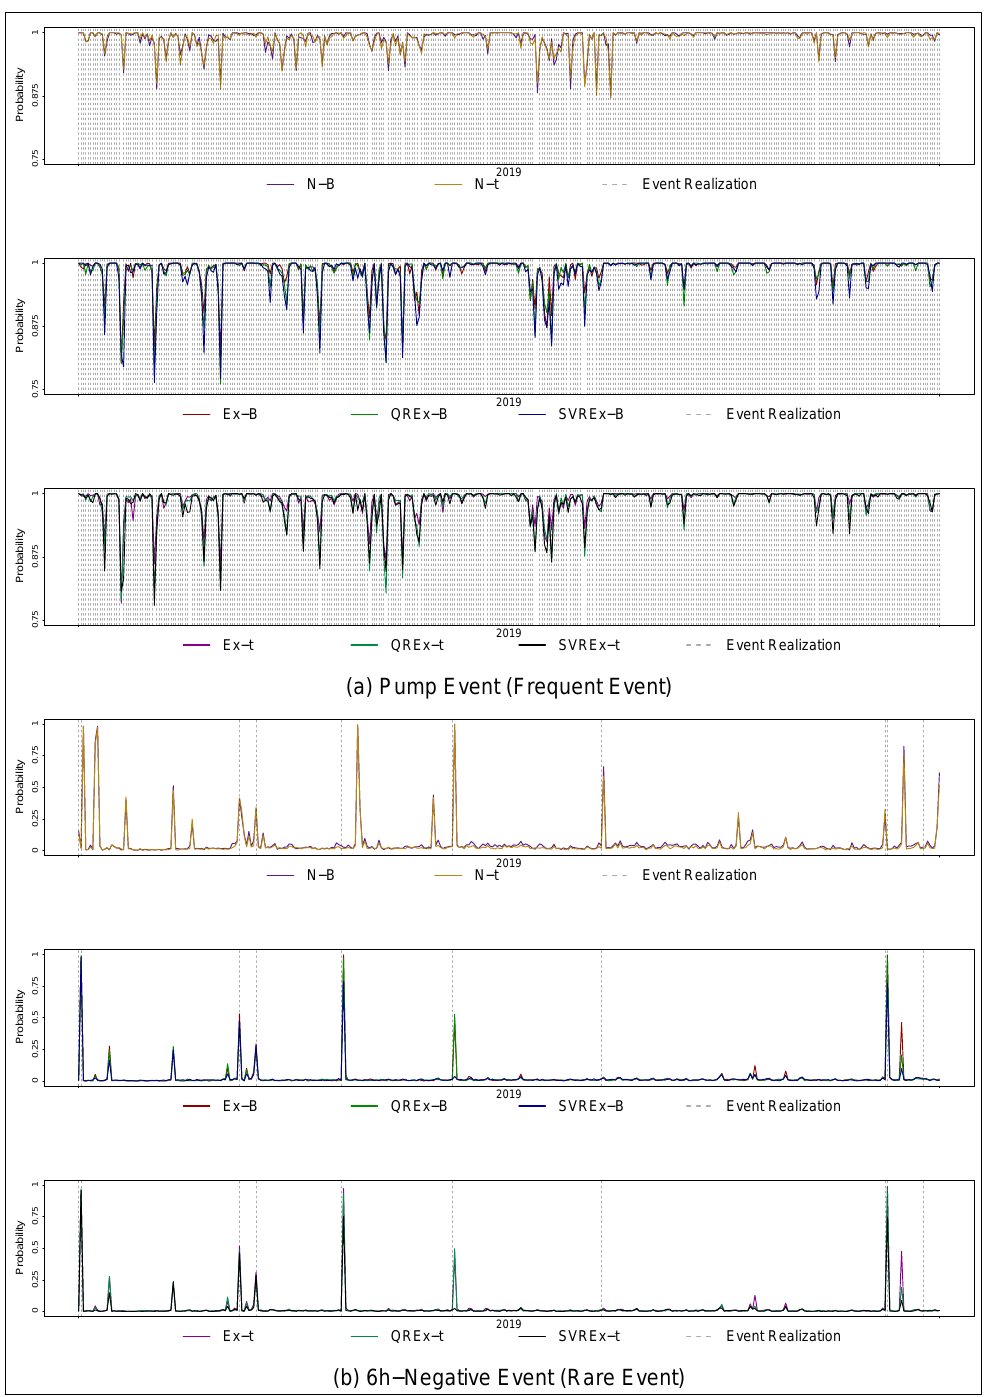
Figure 3. Probability Forecast and Realization Time Series for Events: ( a ) Probability Forecast Time Series per Model for Pump Event; ( b ) Probability Forecast Time Series per Model for 6h- Negative